Question: What caption would you write for this figure?
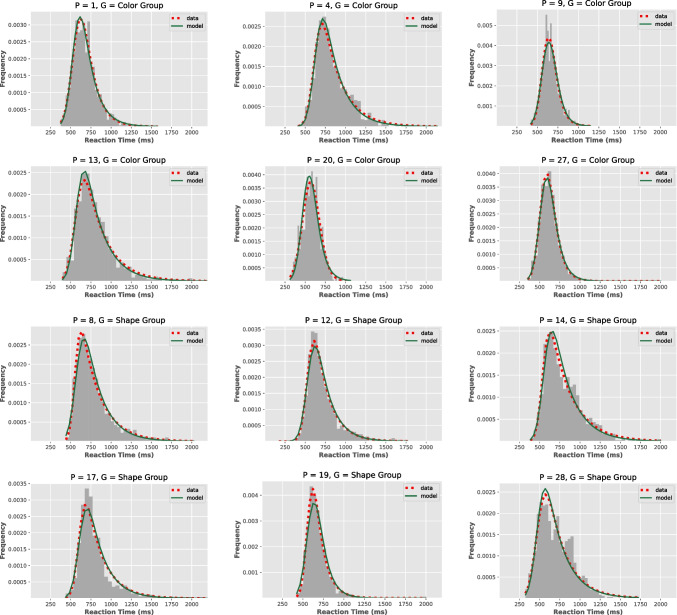
Answer: Ex-Gaussian distributions of 12 participants’ reaction times. Best model-free fits to the data are shown in red and model-predicted distributions are shown in green. This figure is an expansion of Fig. 5 . “P” is participant number and “G” is group membership which is be either “color” or “shape” based on the participant’s learning experience. Note that all versions of the model are equally good in predicting the distributions